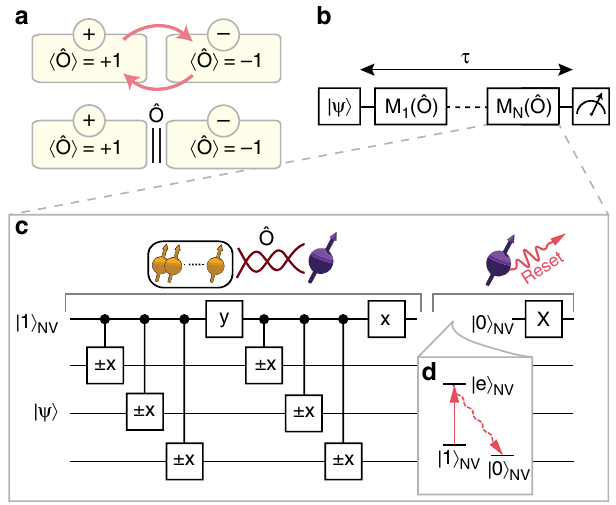
Figure 1 | Concept and experimental sequence. ( a ) Quantum Zeno subspaces. The state space of a quantum system is divided into two subspaces (yellow boxes) of an observable ^ O . Plus and minus signs indicate eigenvalues of the associated operator. Coherent transitions between the two subspaces occur while the system is unperturbed (top, red arrows) but are strongly inhibited if ^ O is repeatedly projected (bottom). ( b ) Experimental sequence. After initialization in | c i , N equidistantly distributed projections M ( ^ O ) (see equation (1)) are applied during a total evolution time t and the state of the system is read out. ( c ) Realization of M ð ^ O ¼ ^ s x ^ s x ^ s x Þ for three nuclear spins. First, the state of the nuclear spins (yellow) is entangled with the ancilla electron-spin state (purple). Second, the electron spin is projected and reinitialized in |1 i NV (see also d ) through a long 30 m s optical pumping pulse to |0 i NV and a subsequent microwave p -pulse (X). Such a long laser excitation pulse ensures that the NV is projected. The x and y gates are p /2 rotations around the X and Y axes, respectively. Controlled gates indicate that the direction is determined by the electron spin 28 . See Supplementary Fig. 3 for pulse sequences for projections on one and two spins. ( d ) Relevant electron spin levels for optical re-pumping through selective resonant excitation of |1 i NV to | e i NV . We prepare the nuclear spin states in the h ^ O i¼ þ 1 subspace and associate this subspace with the electron state |0 i NV in the entangling sequence so that the optical projection ideally never excites the NV